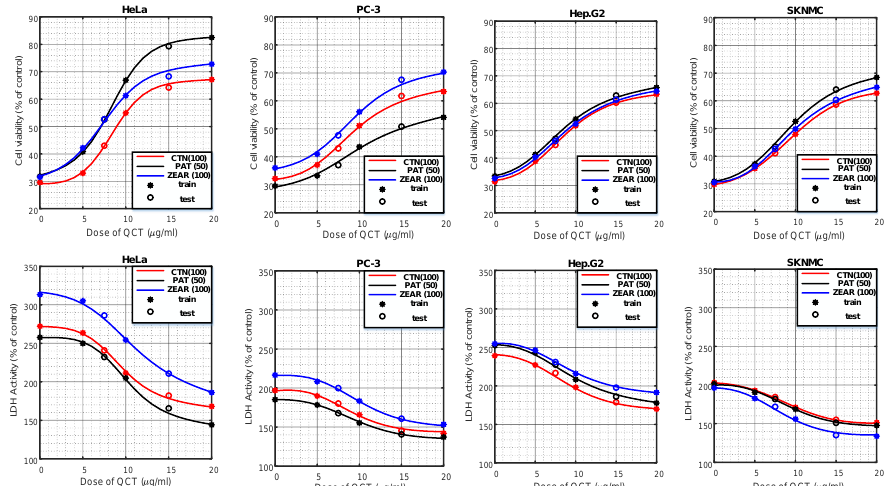
Figure 13. Cell viability and LDH activity predicted by the neuro-model on different cell lines pretreated with QCT and post-treated with various MTX: CTN (100 µ M), PAT (50 µ M), and ZEAR (100 µ M). ‘*’ marks the locations of training data whereas ‘o’ marks the location of test data.